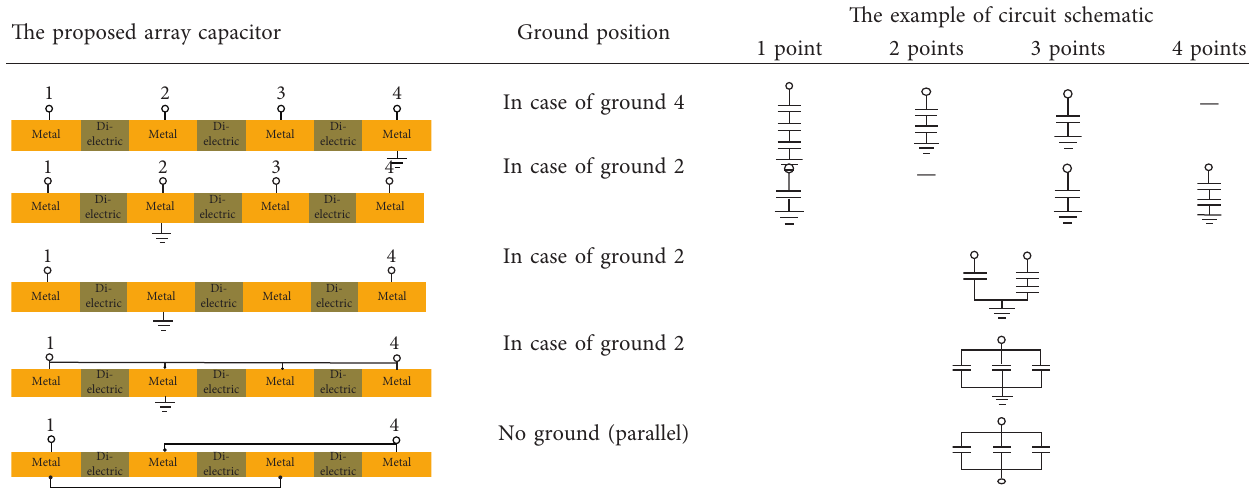
Table 1: The example of the decoupling capacitor using the structure shown in Figure 1.